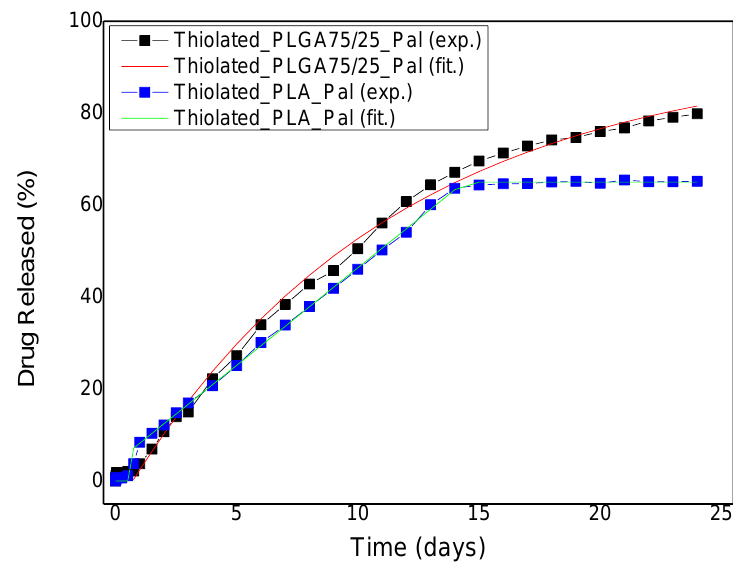
Figure 12. Paliperidone release profile for thiolated PLGA and PLA microspheres. The experimental data are shown as symbols and the fitting data as a continuous line.